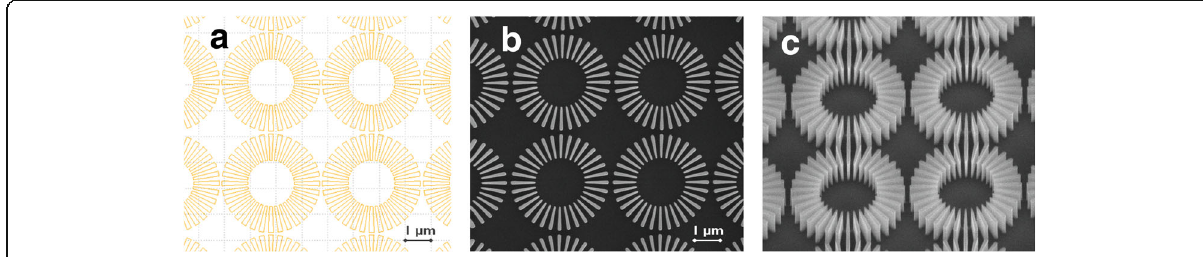
Fig. 1 Wagon-wheels as designed on mask ( a ) and after the nanofabrication process: top view SEM ( b ), tilted view SEM ( c )